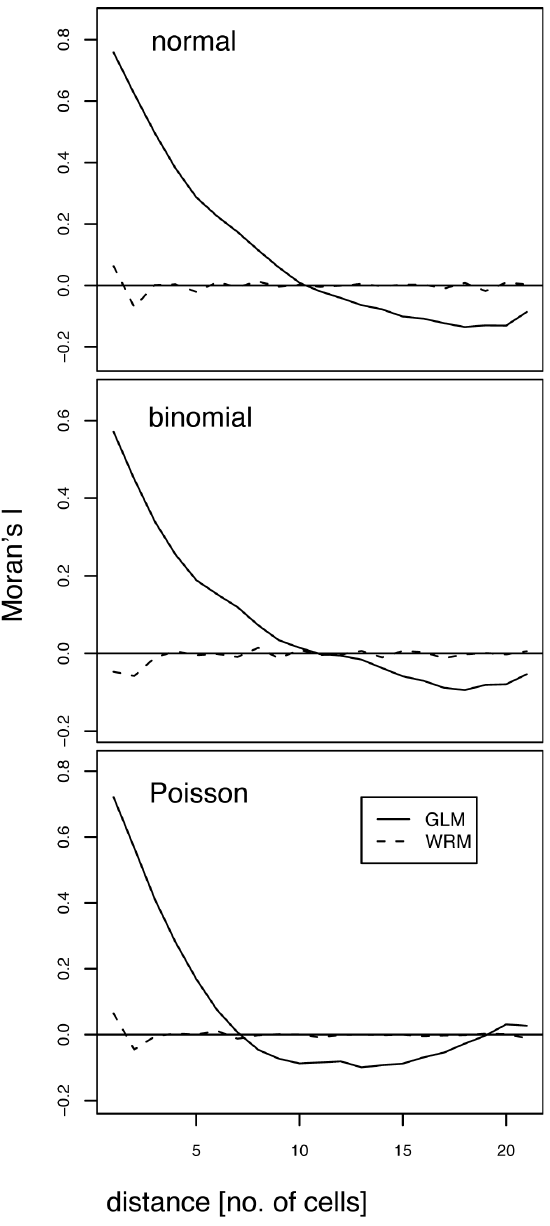
Fig. 2. Correlograms of one realisation for each of the three differ- ent distributions (normal, binomial, Poisson) and the methods compared.